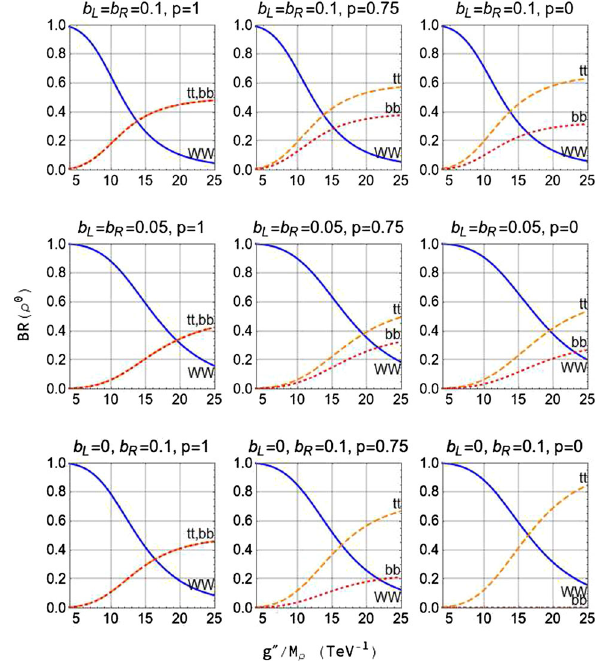
Fig. 4 The principal branching ratios of the neutral vector resonance as functions of g (cid:2)(cid:2) / M ρ in the approximation of the leading order in g (cid:2)(cid:2) and x a = M a / M ρ = 0, where a = W , Z , t . The blue solid line stands for the WW channel, the orange dashed line for the tt channel, and the red dotted line represents the bb